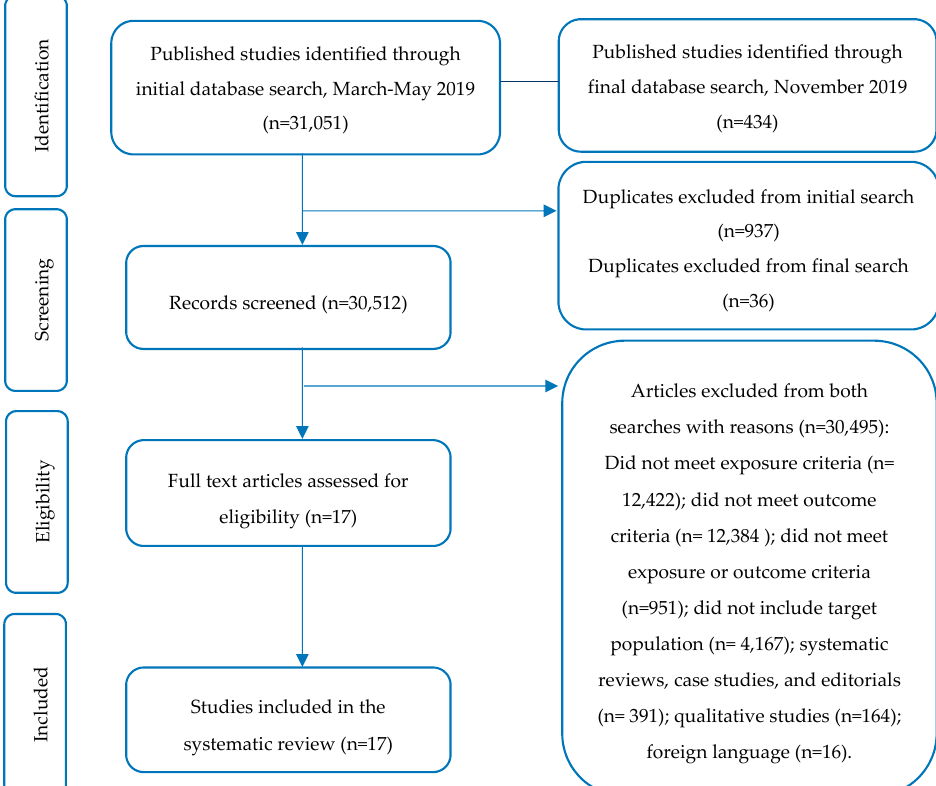
Figure 2. Flow chart representing selection of studies in the systematic review.